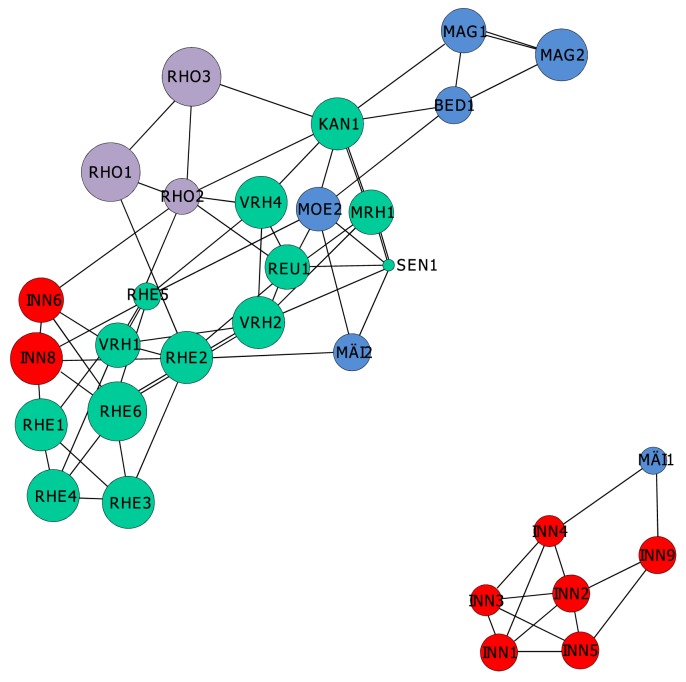
Allelic richness and population-specific inbreeding coefficients (F
IS) of 20 nuclear SSR in Myricaria germanica.
A and E. Relationship with elevation. B and F. Relationship with log10-transformed census population size. D. Relationship between allelic richness and F
IS. C and G. Boxplots of allelic richness, grouped by affiliation to genetic clusters (see Fig. 1B). H. Boxplots of FIS, grouped by affiliation to catchment. The values plotted for census population size are midpoints of the estimated intervals of population size. Lines represent linear regressions. Cluster 1: Rhine, Rhone, Ticino. Cluster 2: Inn.